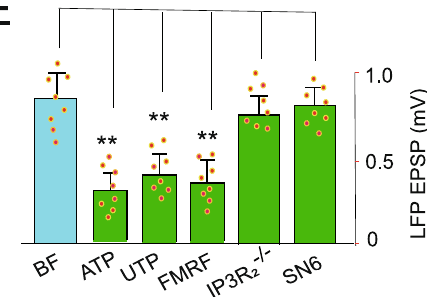
Fig.4|SmallCa 2+ transientsblockedsensorytransmission.A Typicalrecordings showingthedifferencesinmembranepotential(MP)duringsleepandawakestates. B Typical images showing a whole-cell recorded neuron (Alex 488 was dilated in intracellular solution) and images of astrocytes transfected with GCaMPf6. Scale bar = 20 µ m. C Typical traces of whisker stimulation-induced EPSPs recorded with whole-cell recordings (VmEPSPs) and local fi eldrecordings(LFPEPSPs) during